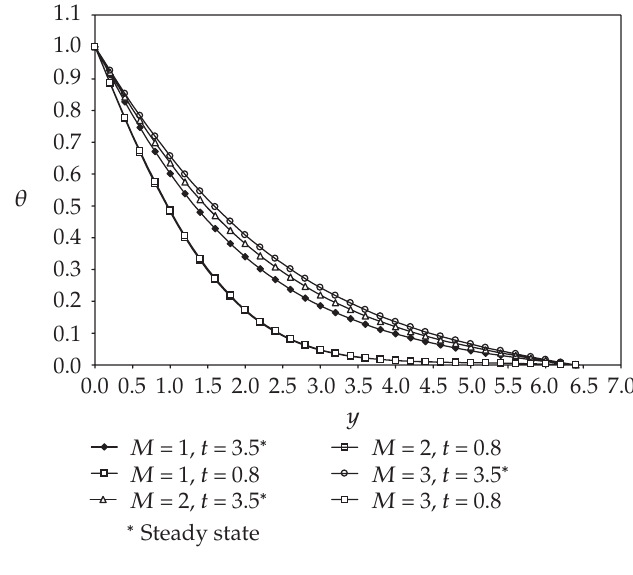
Figure 5.4 . Transient temperature profiles for the di ff erent values of M and for the values x = 1, F = 0 . 01, m = 1, and Pr = 0 . 7.